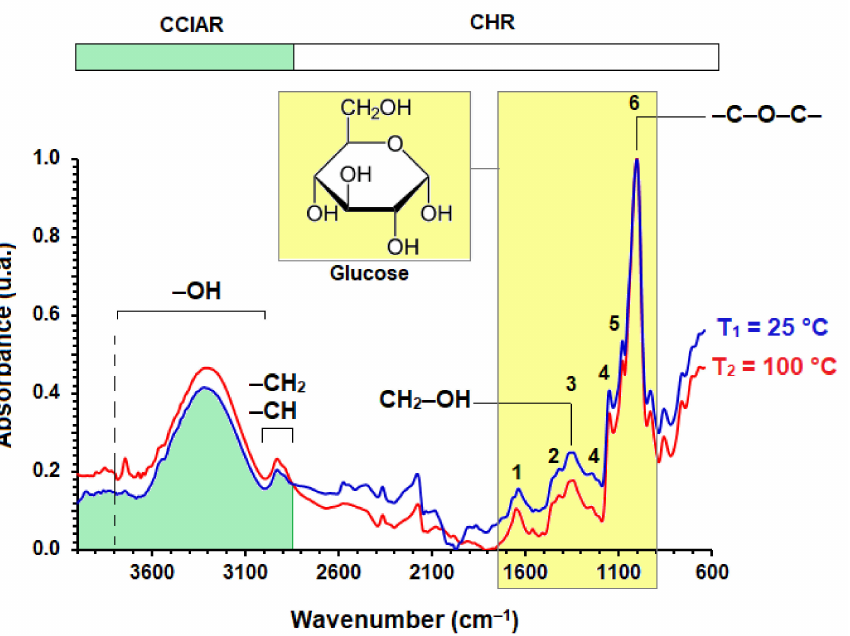
Figure 1. Averaged infrared spectra of starch at 25 ◦ C (T 1 = 25 ◦ C) and after to be subjected to thermal stress at 100 ◦ C (T 2 = 100 ◦ C). (CCIAR and CHR mean chain-chain intermolecular association region and chain hydration region,